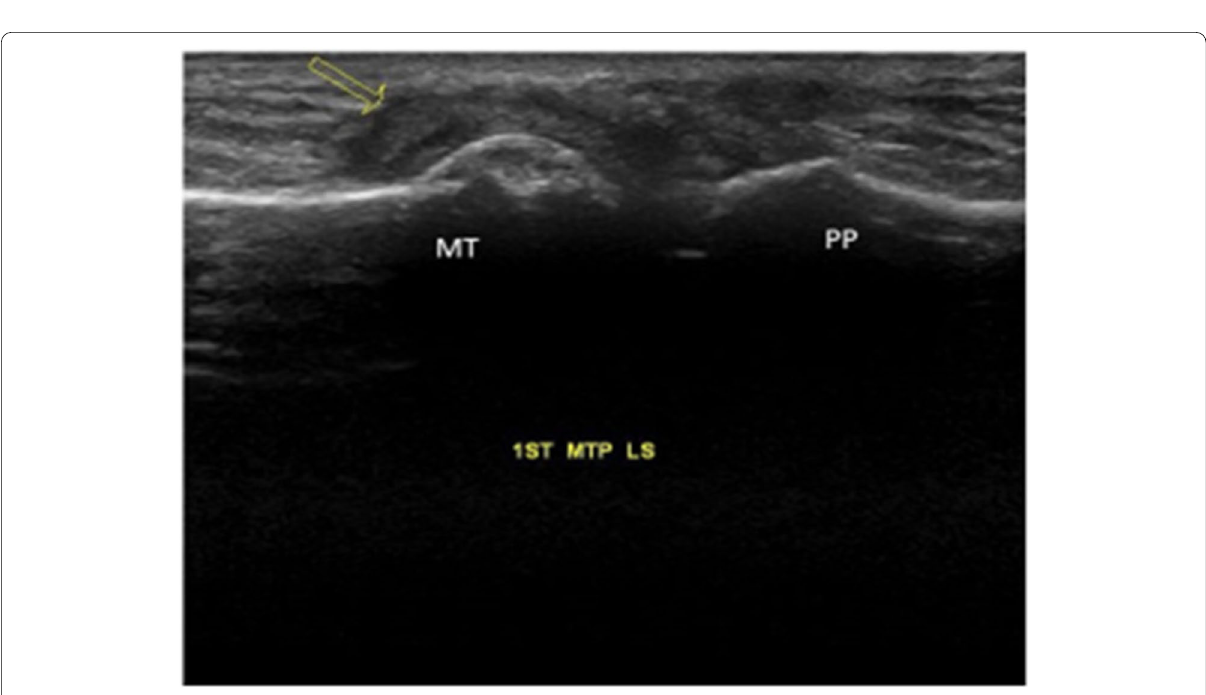
Fig. 5 Dorsal longitudinal gray scale ultrasound scan of the 1st MTP joint showing tophus